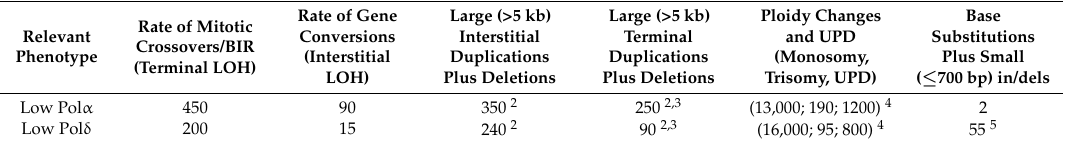
Table 1. Fold elevations of various types of genomic alterations (normalized to a wild-type level) in yeast strains with low levels of Pol α and Pol δ 1